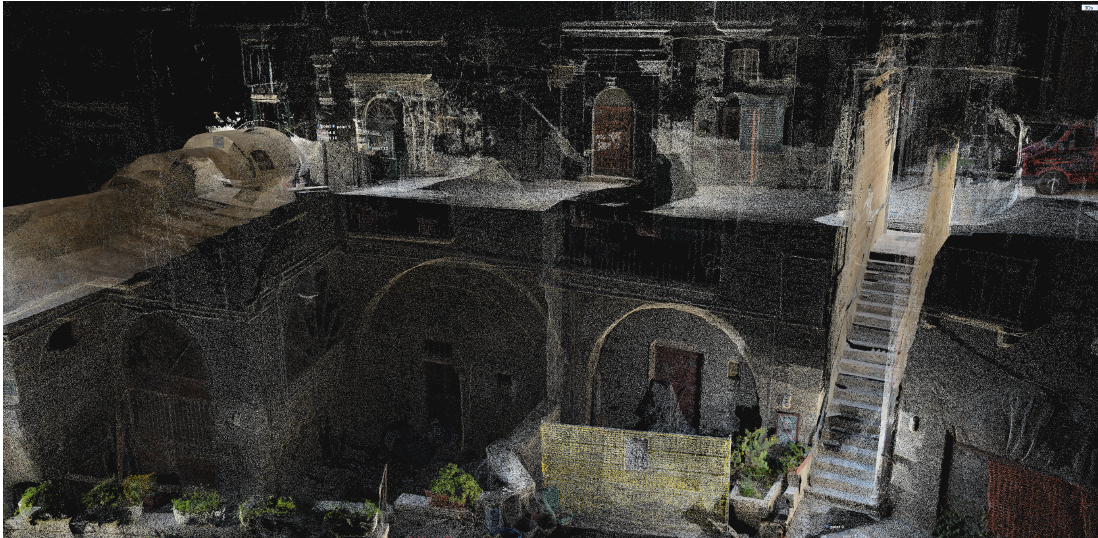
Figure 2. A portion of the 3D point cloud of the alley, depicting the morphological and material complexity typical of the Matera’s Sassi urban